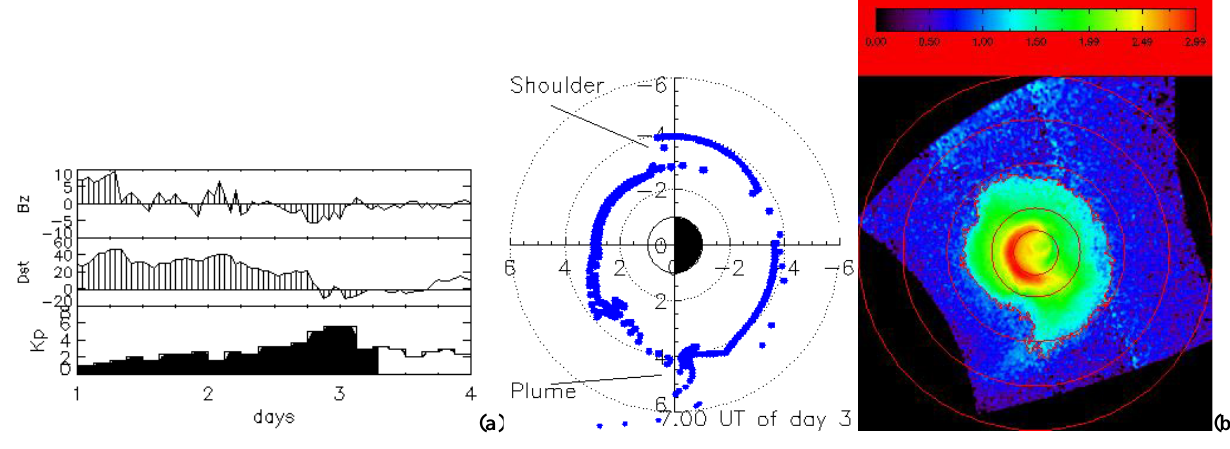
Fig. 5: Same as Fig. 1 for 10 June 2001, 7h00 (left panel (a), simulation) and 7h03 UT